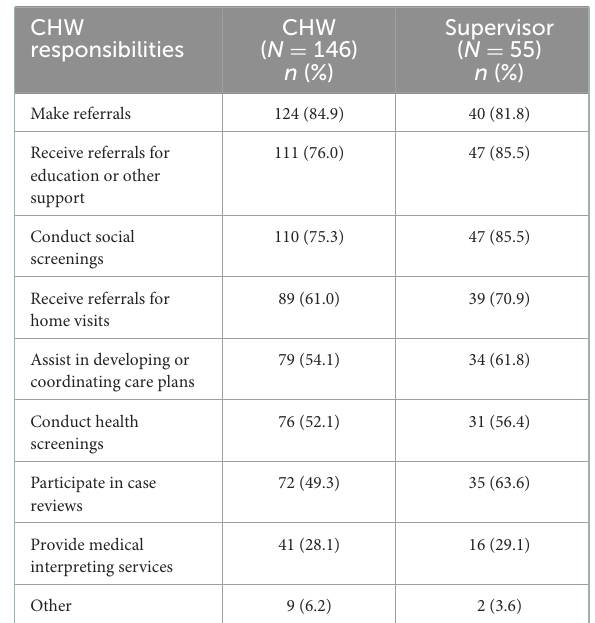
TABLE 5 CHW responsibilities reported by a national sample of CHWs and CHW supervisors working with Medicaid managed care